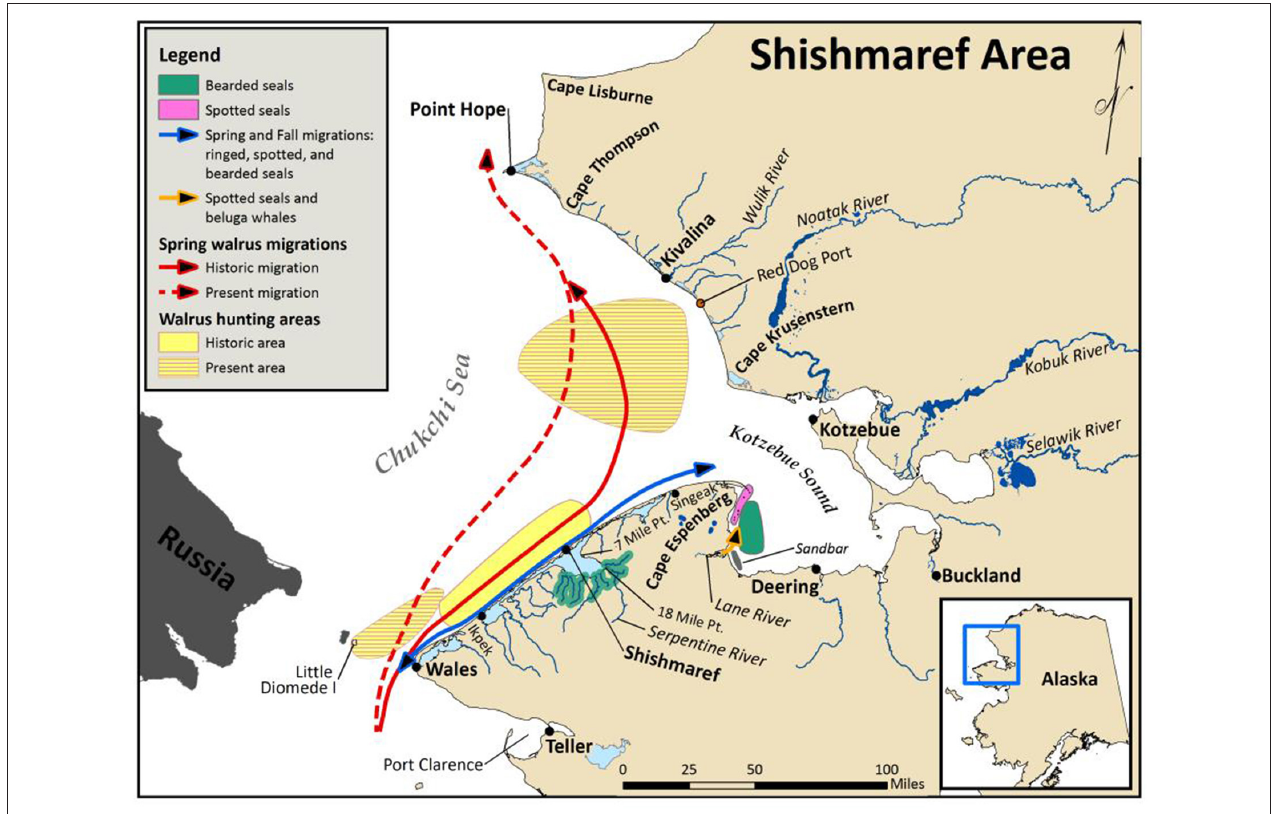
FIGURE 3 | Traditional knowledge about the movements and behavior of marine mammals near Shishmaref, Alaska as described during interviews in January 2016.